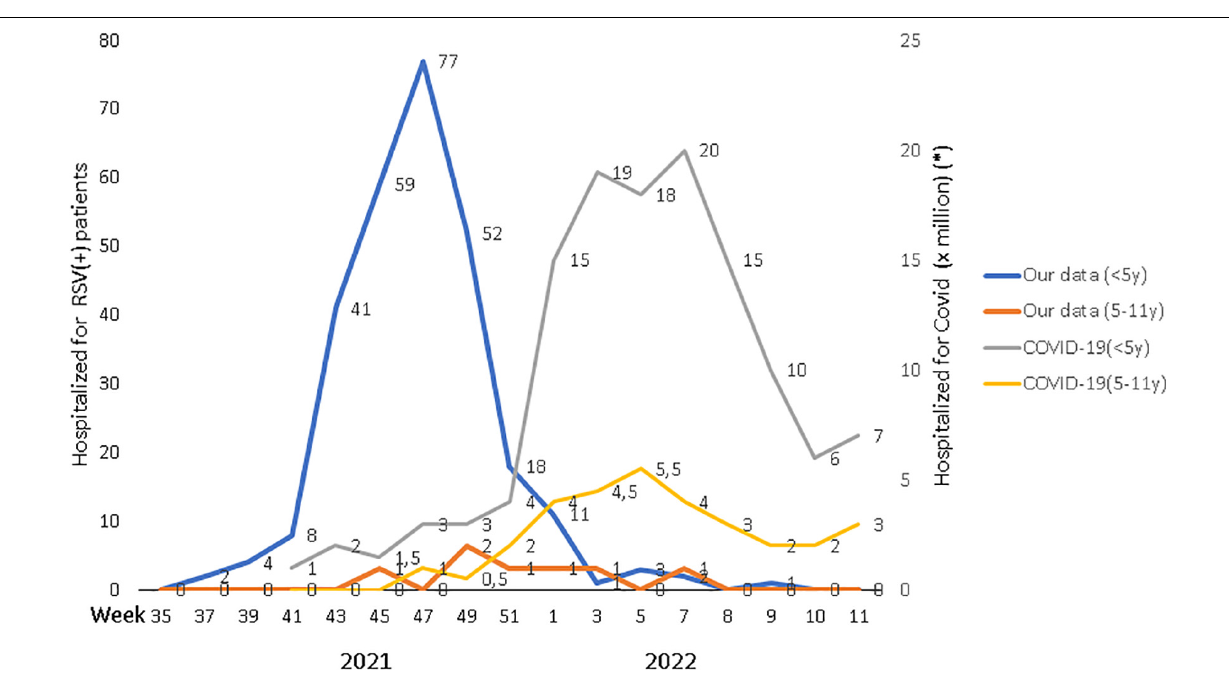
Frontiers in Pediatrics |